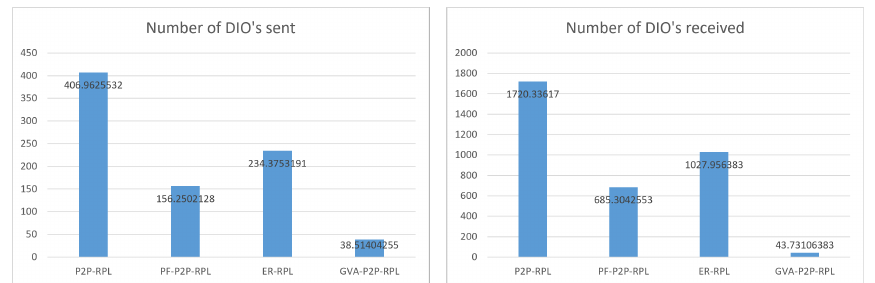
Figure 21. Number of DIOs sent and number of DIOs